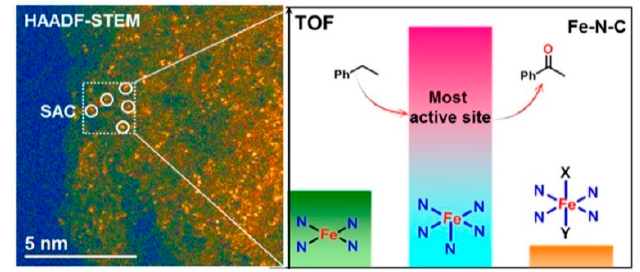
Figure 10. Reproduced from [9], with permission from American Chemical Society, 2017.